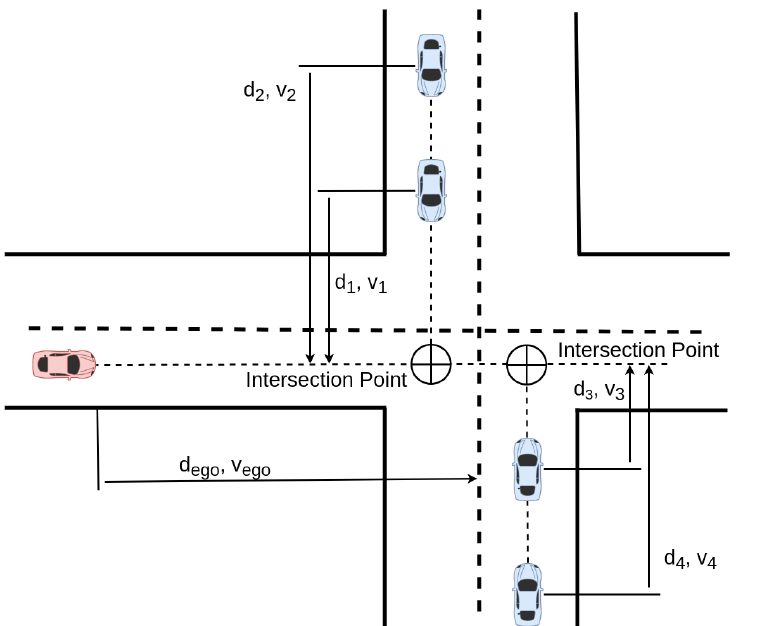
Figure 3. The ego vehicle (red) and the adversary (blue) are represented. The velocity of each vehicle and the distances to the intersection point are represented. This point is defined by the intersection of the trajectories of the